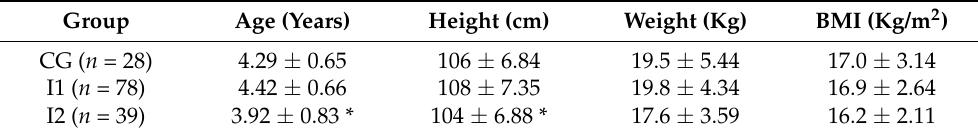
Table 1. Anthropometric characteristics of preschool children.